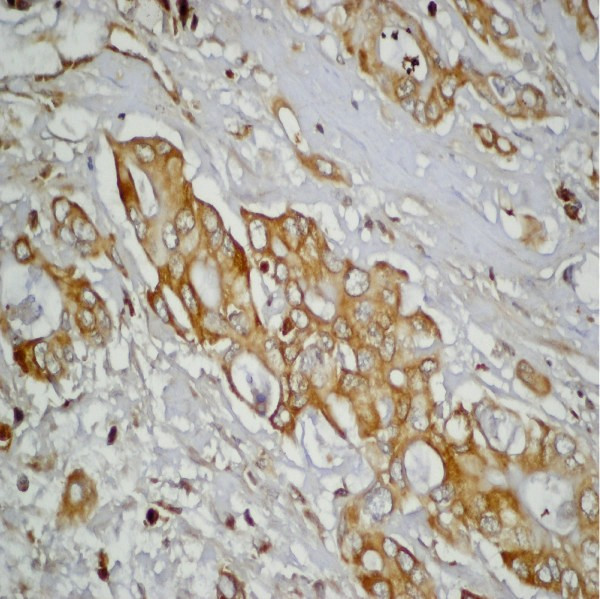
Intense [score 6] cytoplasmic TGF-β1 immunoreactivity of pancreatic ductal carcinoma cells [anti-TGF-β1, original magnification, × 400].